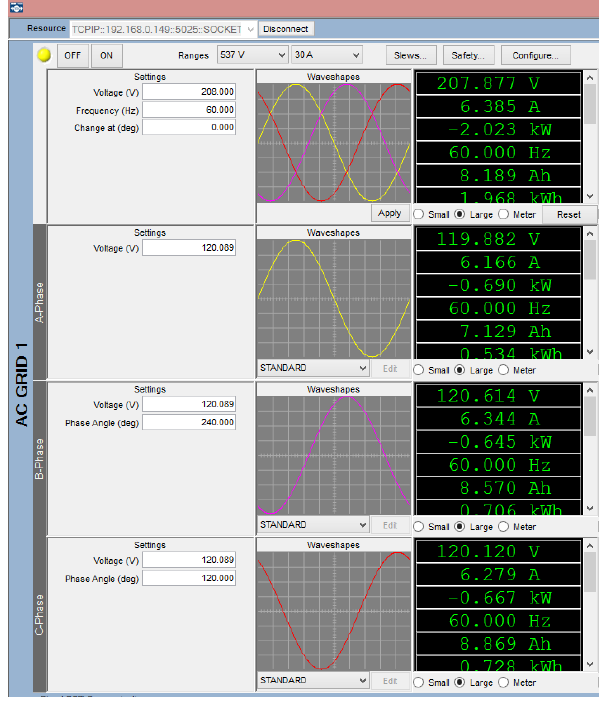
Figure 21. Hardware results using grid simulator NHR 9400 panel for real power = 2 kW and reactive power = 0 var under balanced grid inductances.